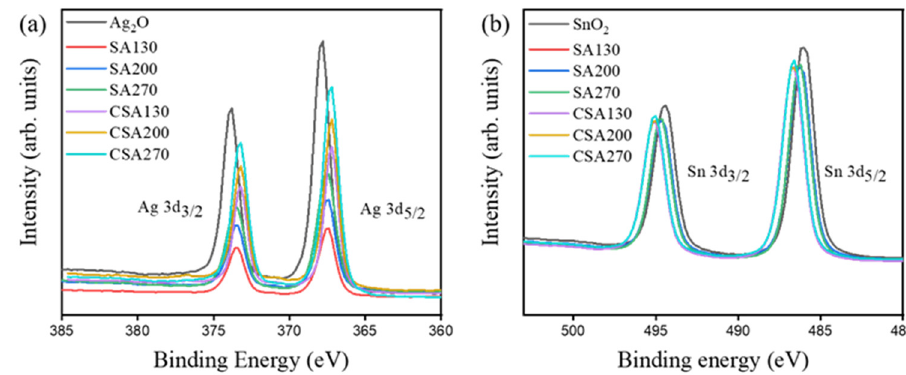
Figure 7: High - resolution XPS spectra in Ag 3d and Sn 3d core - level regions of various thin fi lm samples: ( a ) Ag 3d and ( b ) Sn 3d.